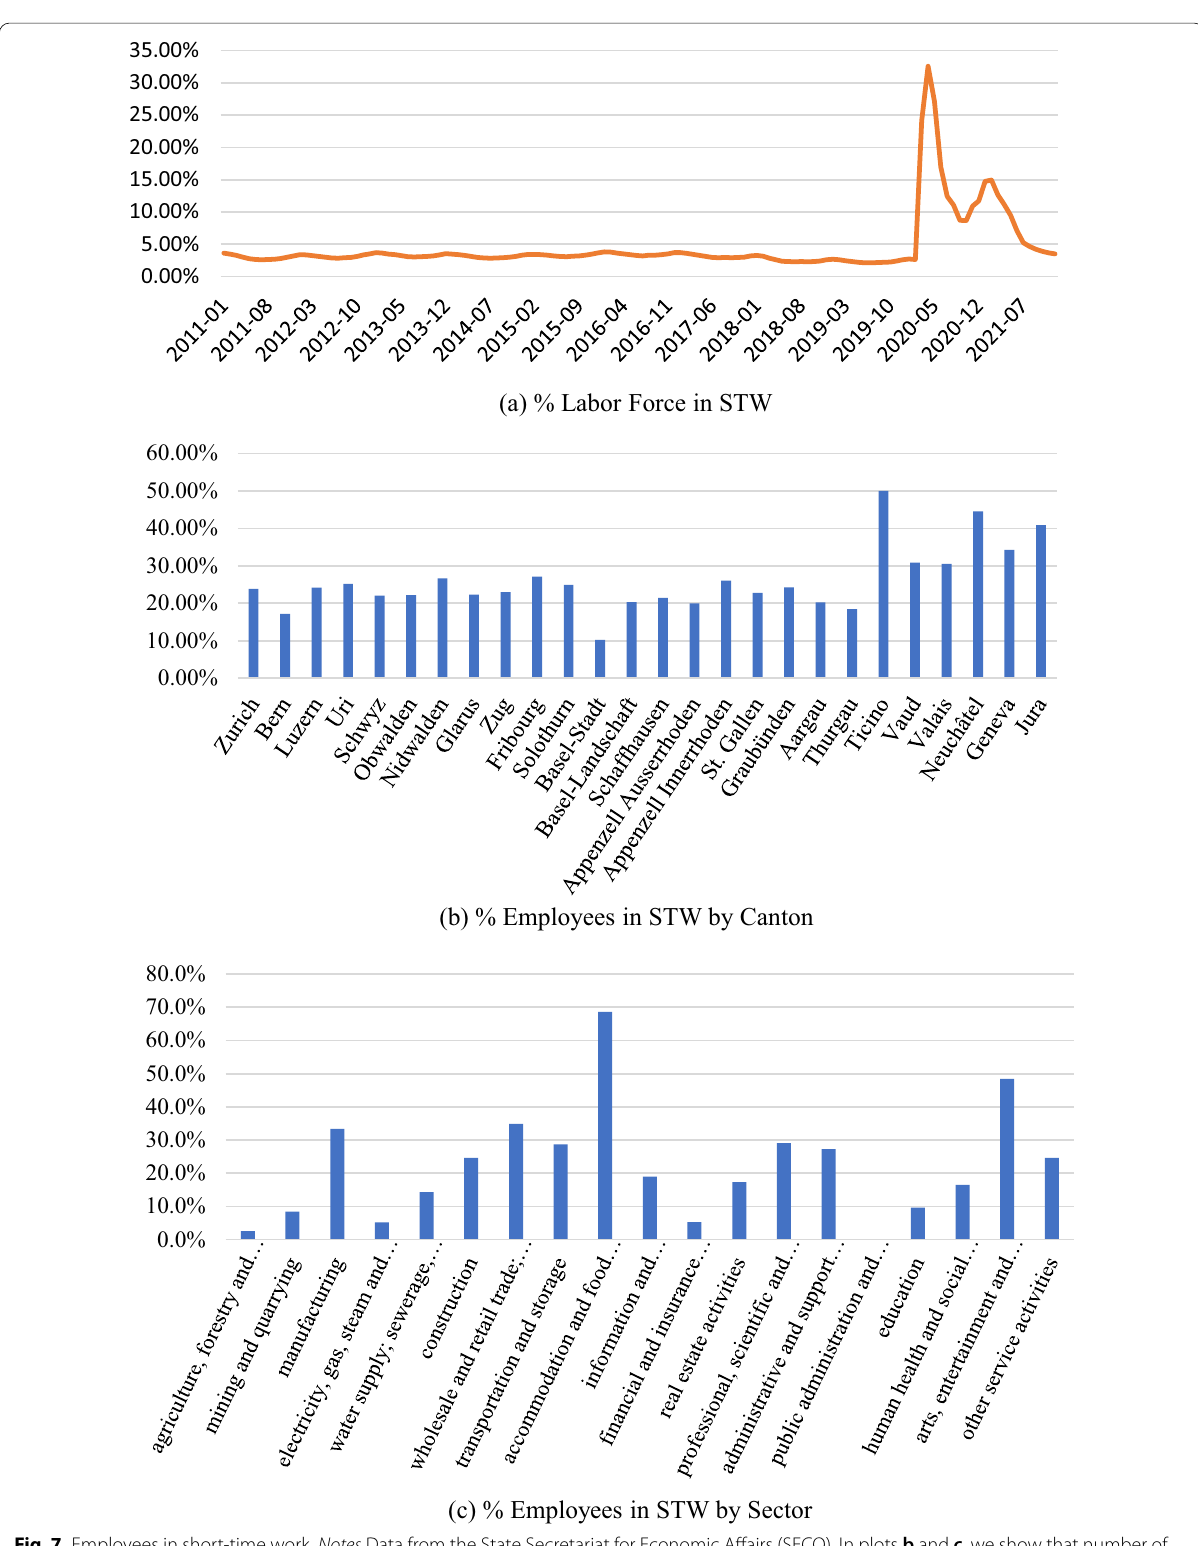
Fig. 7 Employees in short-time work. Notes Data from the State Secretariat for Economic Affairs (SECO). In plots b and c , we show that number of employees in STW in April 2020, divided by the total number of employees in each canton/sector in